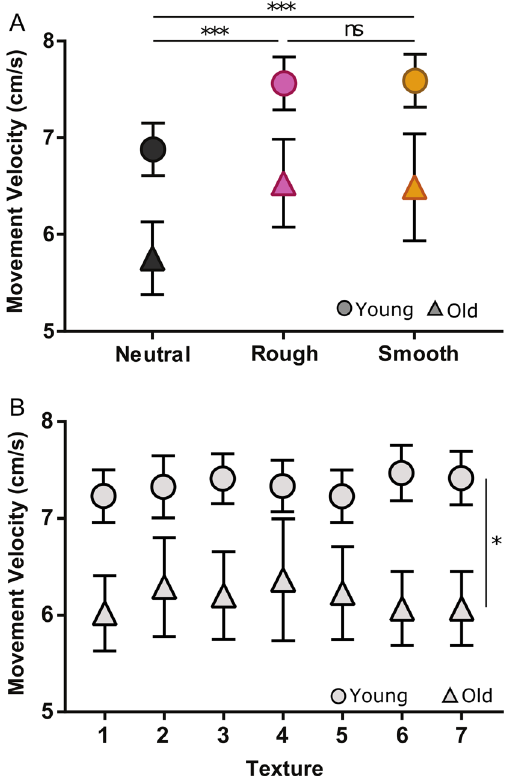
Figure 4. ( A ) Mean finger movement velocity (cm/s) for younger (dot symbols) and older adults (triangle symbols) for each sound condition: Squeaking (pink), Rubbing (yellow) and Neutral (black). ( B ) Mean finger movement velocity (cm/s) for younger (dot symbols) and older adults (triangle symbols) depending on the various roughness textures explored by the participants. The statistics presented are the effects of the Sound conditions for the two groups confounded ( A ) and the main effect of the Groups for all the textures confounded ( B ). ns non-significant, *p < 0.05; ***p <